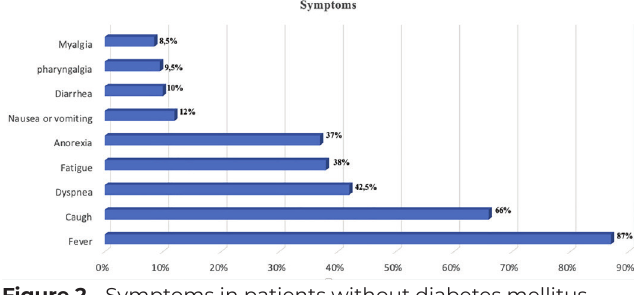
Figure 2 - Symptoms in patients without diabetes